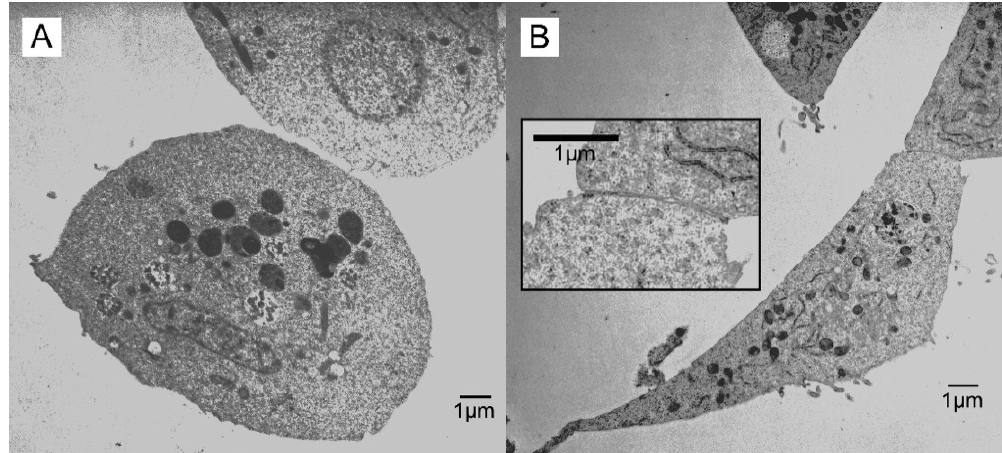
Figure 3. Cell-to-cell contacts in 20-HE treated Sf 21 cell cultures. ( A ) A cell showing only a single finger-like projection with no additional membrane or closely associated cytoplasmic elaborations. ( B ) Close apposition between elongated cells. Inset is at greater magnification and shows no syn-aptic or septate junction-like morphology between the two cells.